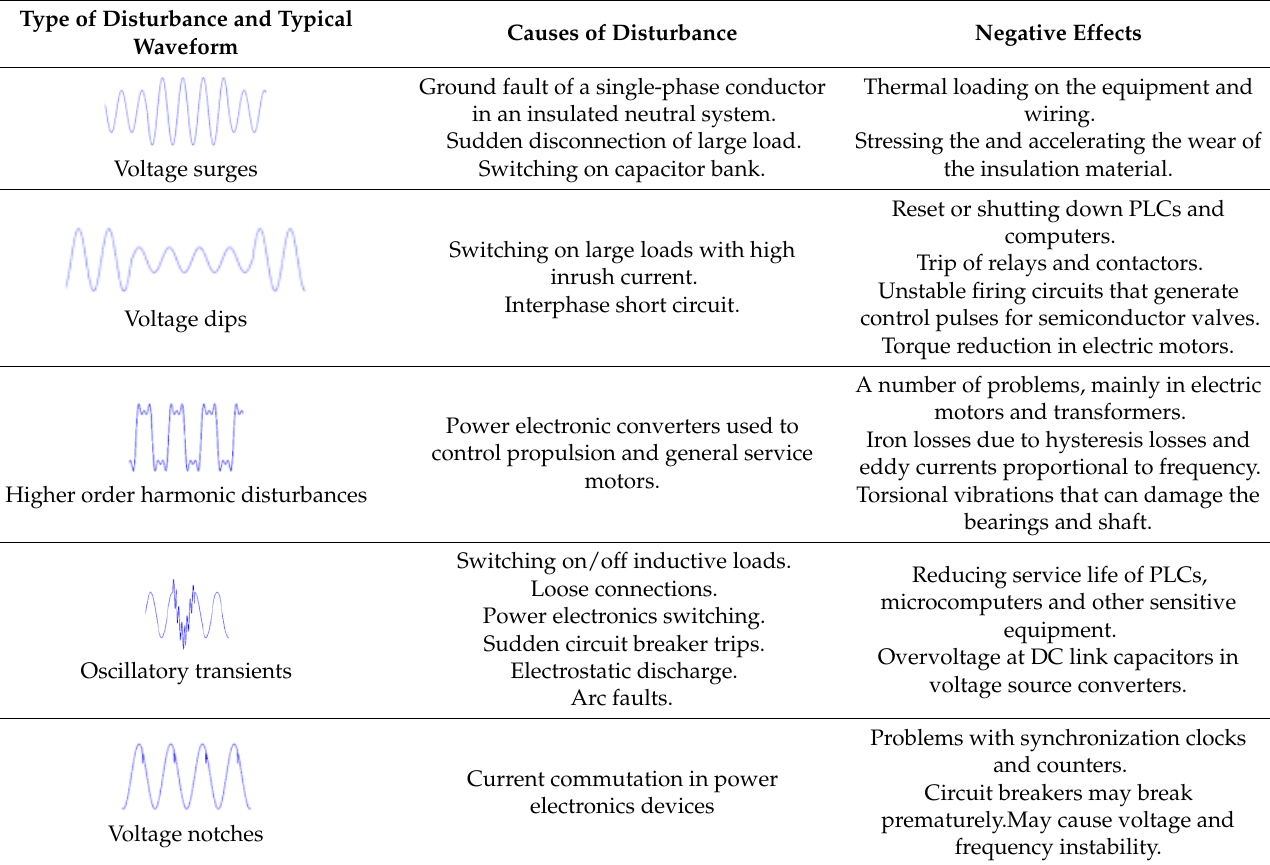
Table 1. Summary of power disturbances, their causes and